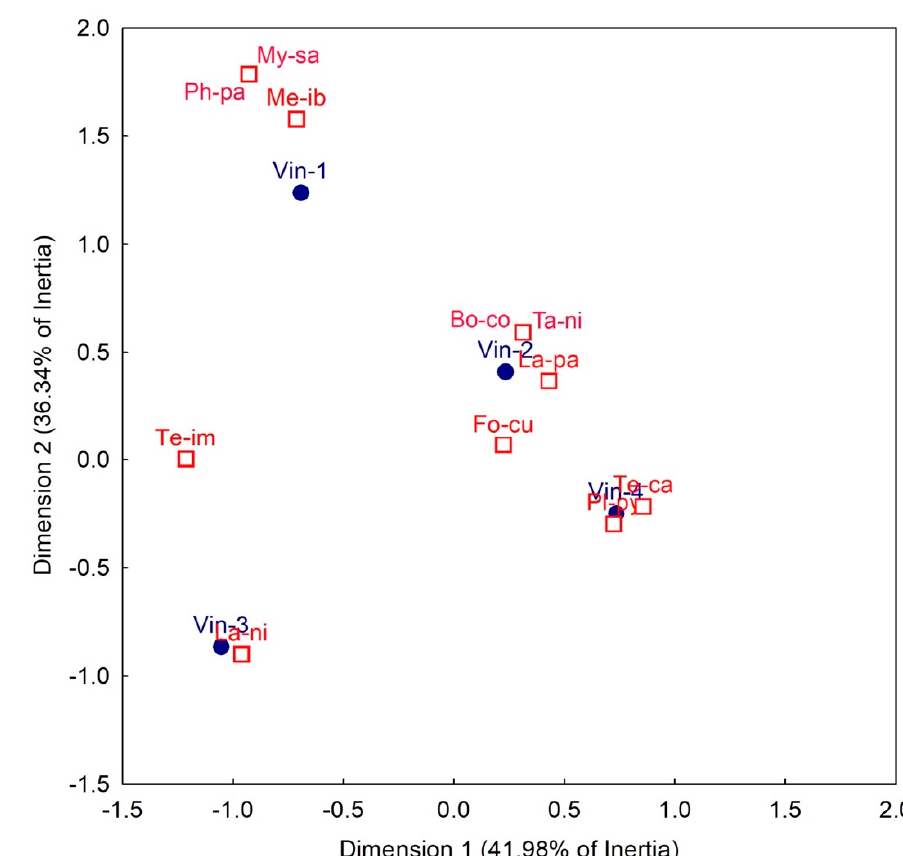
Figure 2. Relative abundance (%) of ant species collected in each vineyard. Relative abundance was calculated as the ratio between the number of each ant species and the total number of ants collected.